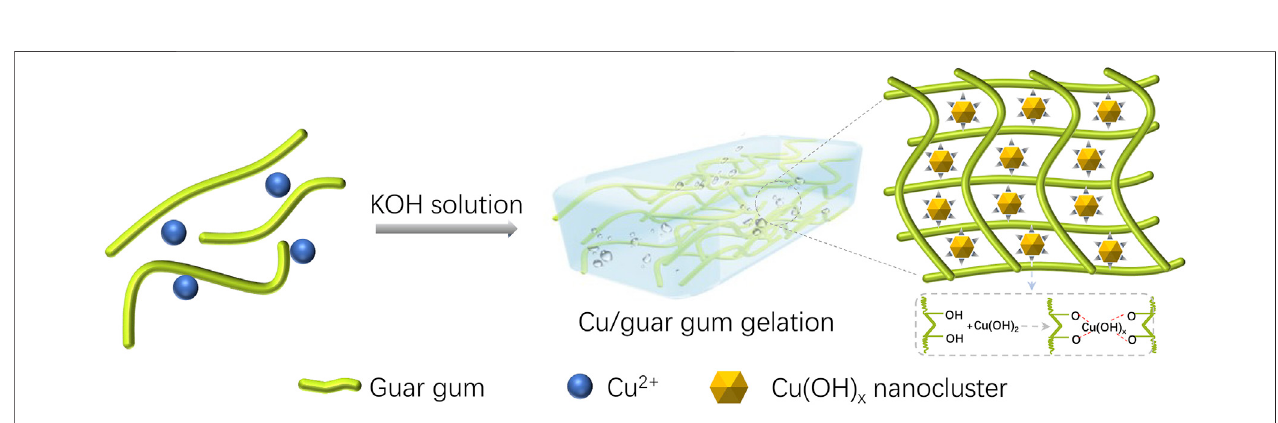
FIGURE 6 | schematic illustration of the rapid gelling process of Cu/GG hydrogel.